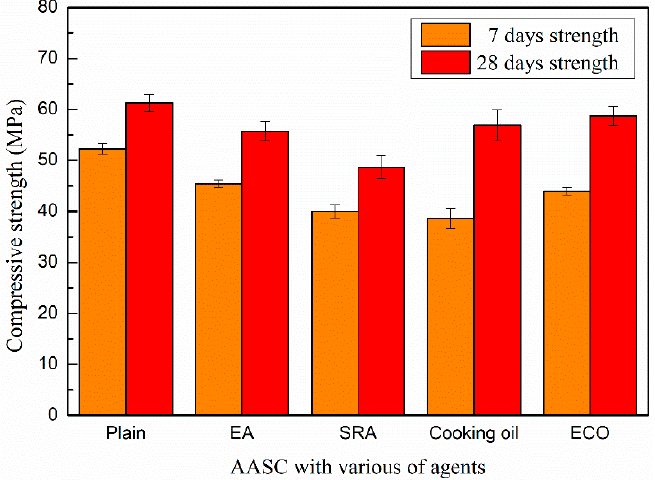
Figure 5. Compressive strength of AASC with various of agents.